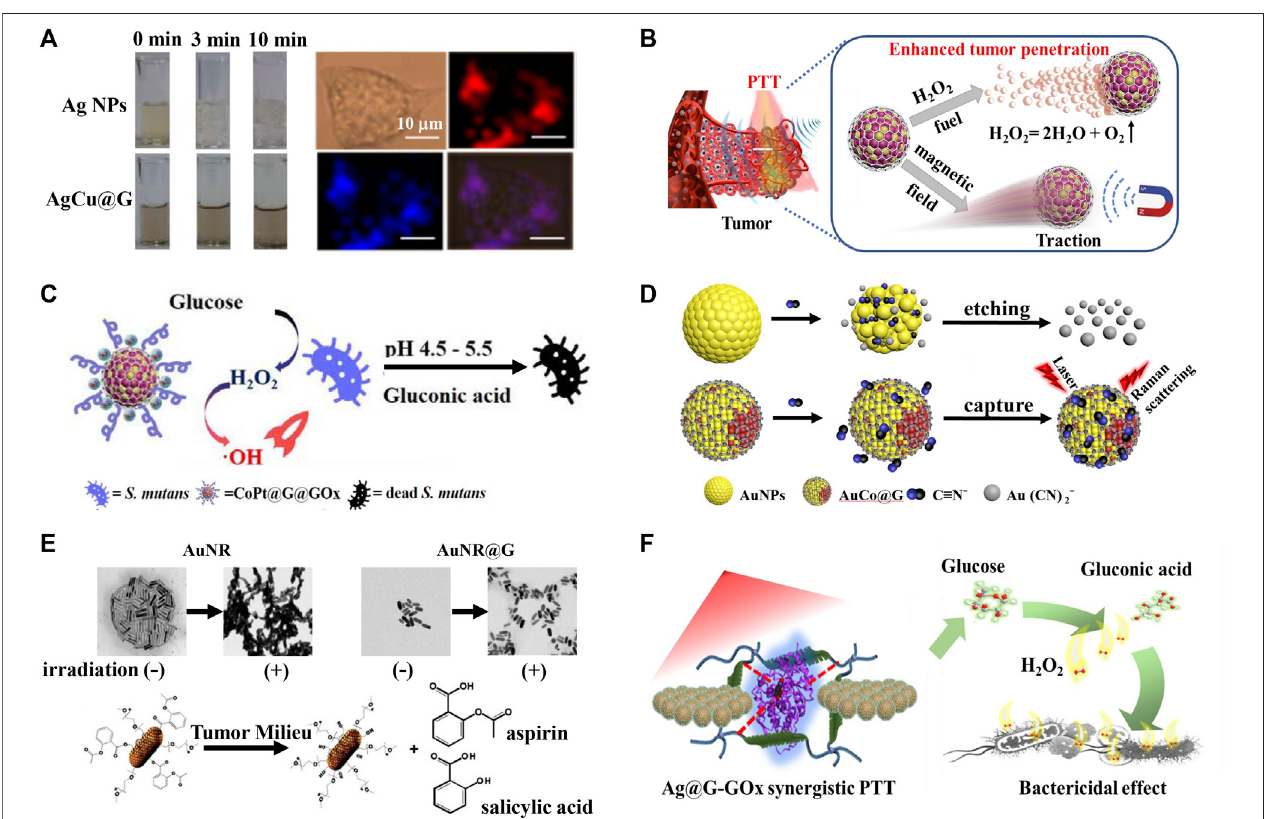
FIGURE1| Metalgraphiticnanocapsules-basedtheranosticsinnon-intrinsicphysiologicalharshconditions. (A) OxidationresistanceofAgCu@GandAgCu@Gfor multimodal cellular Raman imaging (Song et al., 2014). (B) Illustration of the CoPt@G propelled navigator to enhance penetration and PTT action against tumor cells (Zhangetal.,2021a). (C) IllustrationoftheCoPt@G@GOxwithmagneto-actuatedcascadecatalyticactivityforthetherapyof Streptococcusmutans bio fi lm(Dongetal., 2022). (D) AuCo@G with corrosion resistance for direct capture and SERS analysis of the CN − (Zhang et al., 2019). (E) AuNR@G-P-aspirin for enhanced NIR- mediated PTT of solid tumor and simultaneously inhibit PTT-induced in fl ammatory response (Dong et al., 2018). (F) Thermostable Ag@G-GOx synergistic PTT platform for bacterial elimination (Liu et al., 2022).